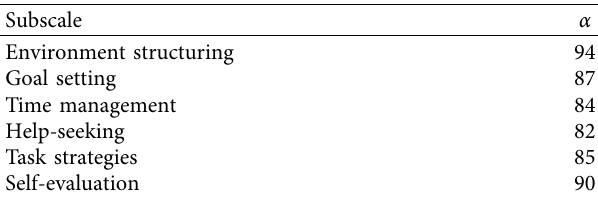
Table 1: Internal consistencies for each subscale: students’ attitude